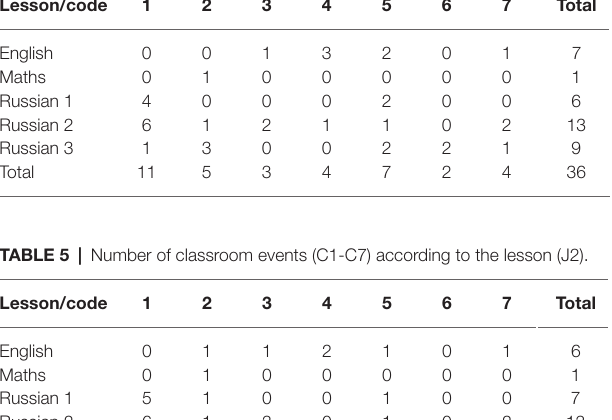
TABLE 4 | Number of classroom events (C1-C7) according to the lesson (J1). Lesson/code